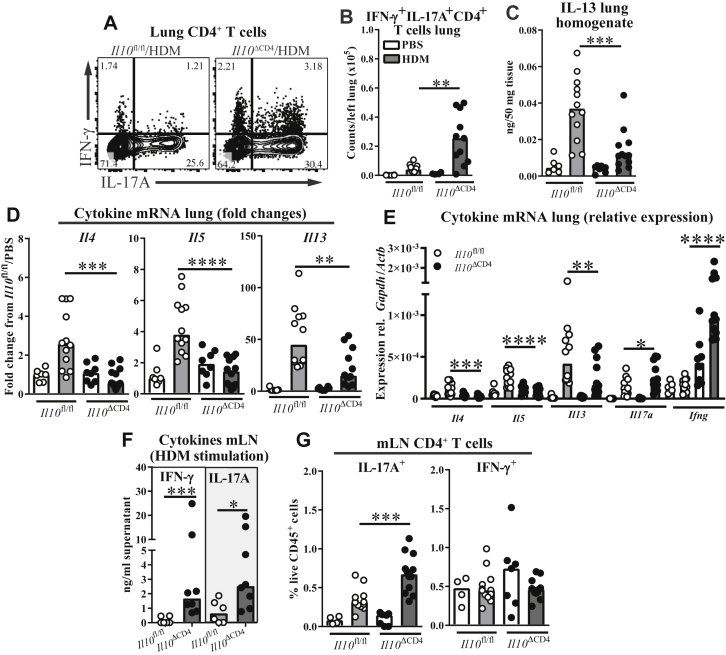
TH cell cytokines in HDM-treated T cell–specific IL-10 knockout mice. A, Representative flow cytometric plots showing intracellular cytokine staining in lung CD4+ T cells. B, Quantification of numbers of double-positive cells in Fig E2, A. C, IL-13 protein concentration in lung homogenate. D, Fold changes in cytokine mRNA expression in homogenized lung tissue. E, 2−ΔCT relative expression values of the indicated cytokines in lung tissue. F, IFN-γ and IL-17A concentrations in supernatants of mLN cell suspensions from HDM-treated mice stimulated with HDM for 4 days. G, IL-17A+ and IFN-γ+ CD4+ T cells as percentages of total CD45+ leukocytes in mLNs. Data are pooled from 2 experiments and shown as medians and individual replicates (n = 4-12 per group). *P < .05, **P < .01, ***P < .001, and ****P < .0001.